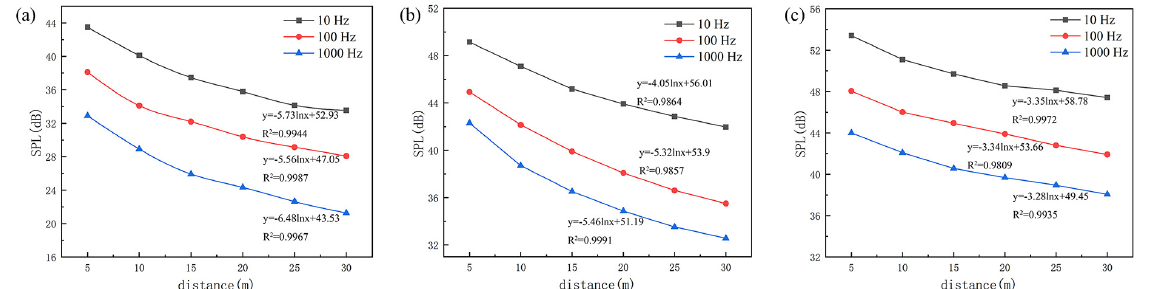
Fig. 14. Far-field sound pressure level decay: (a) Far-field noise attenuation at 300 km/h (b) Far-field noise attenuation at 400 km/h (c) Far-field noise attenuation at 500